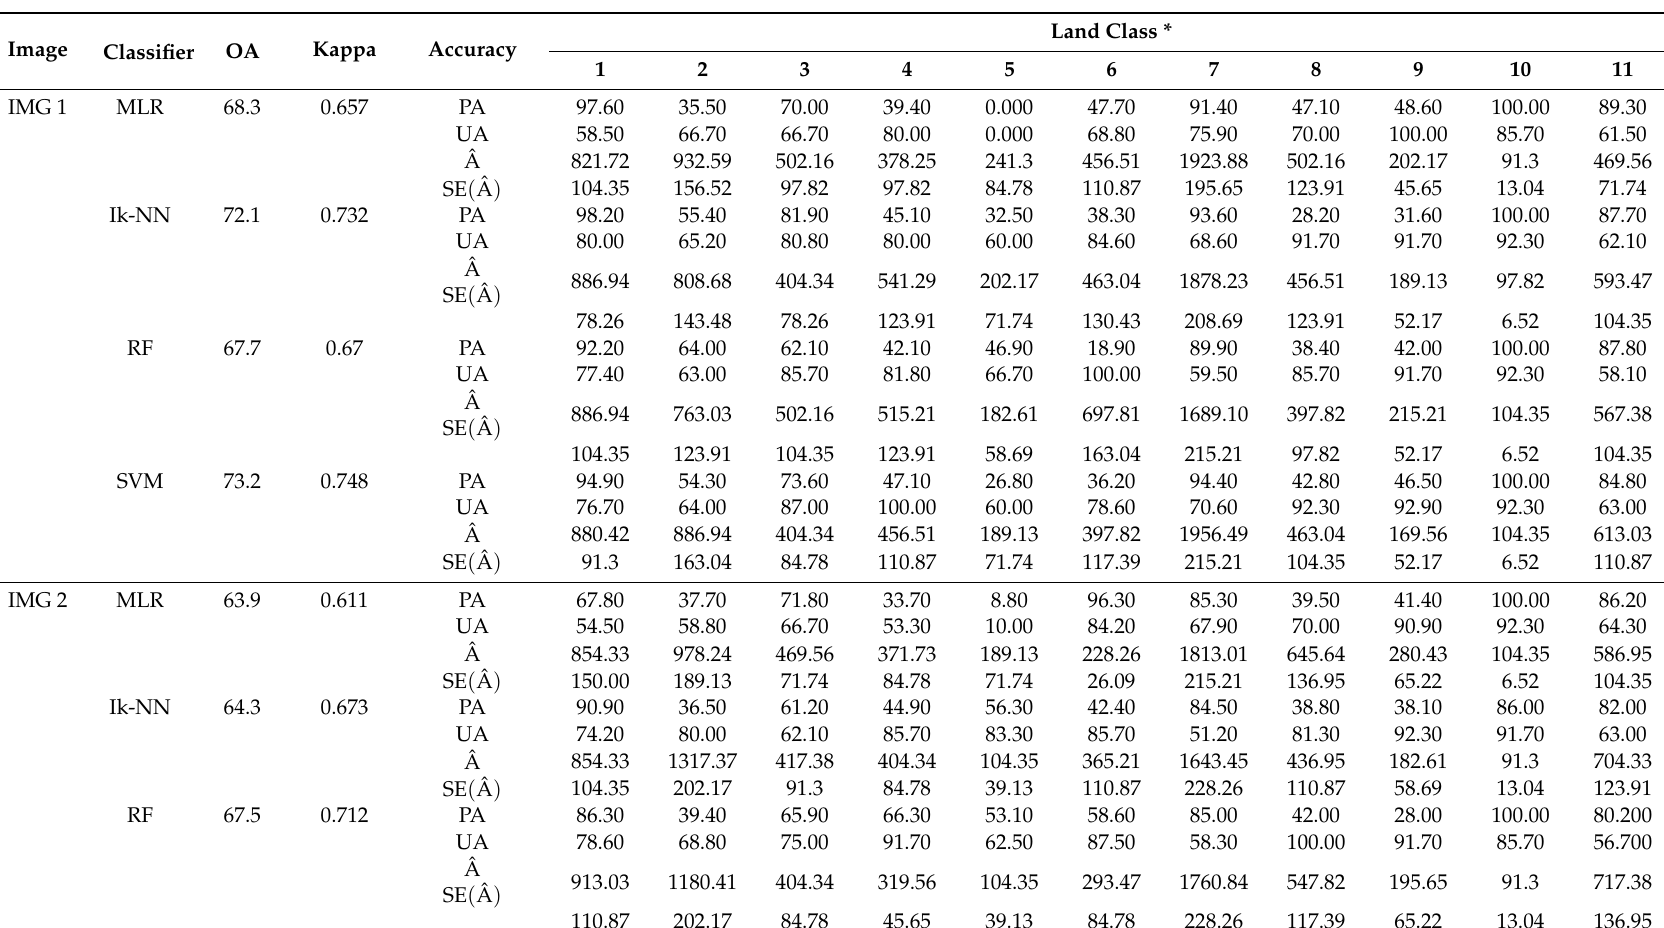
Table 6. Accuracy estimates: OA = overall accuracy, K = Kappa, PA = producer’s accuracy, UA = user’s accuracy, ˆA = class area estimate (km 2 ), SE ( ˆA ) = standard error of class area